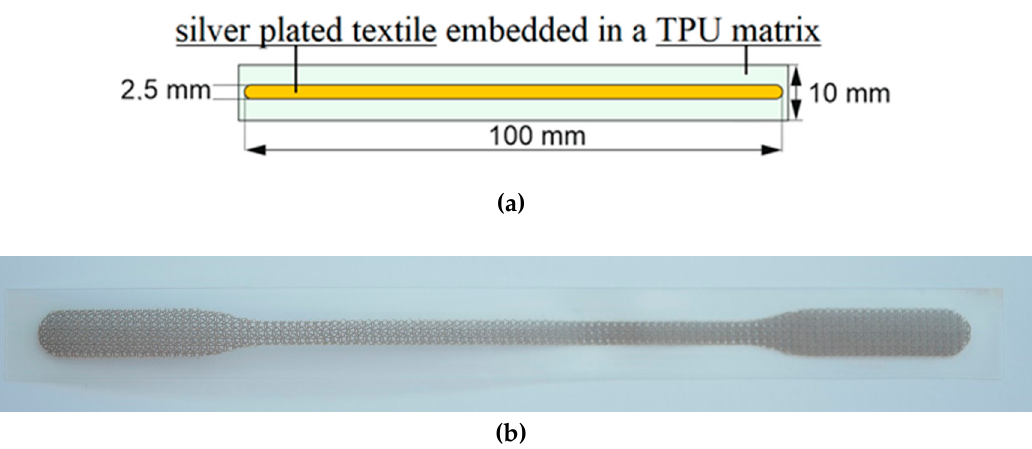
Figure 3. Design of test piece: (a) schematic design; (b) realized test sample.